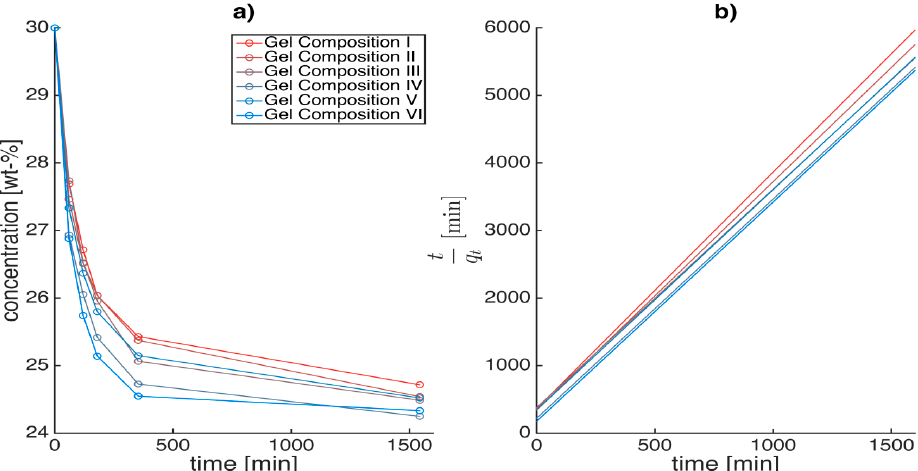
Figure 8. Concentration drop vs. time ( a ) and t / q t vs. time ( b ) when a hydrogel (0 wt % ethanol) of a given alginate concentration and crosslinking degree is placed in a 30 wt % ethanol/water mixture (step 1); 1:5 gel-to solvent ratio, w / w . Similar plots were determined for subsequent higher concentration steps (with constant concentration